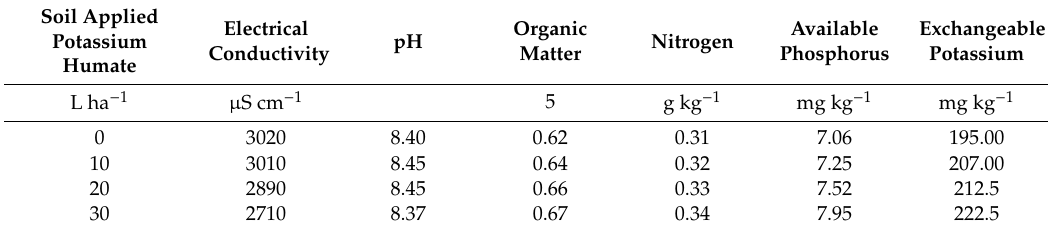
Table 1. The post-experiment soil properties of the experimental site.